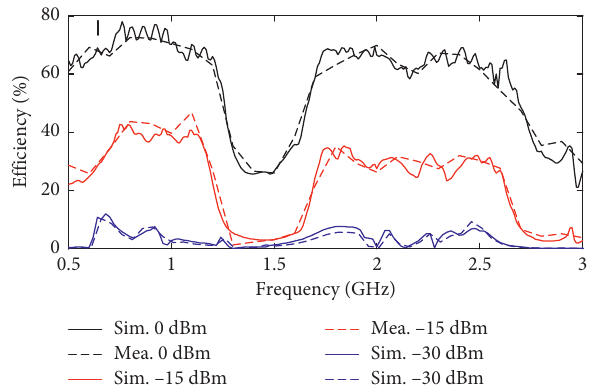
Figure 12: Simulated and measured efficiency of the rectifier vs. frequency at interest input power